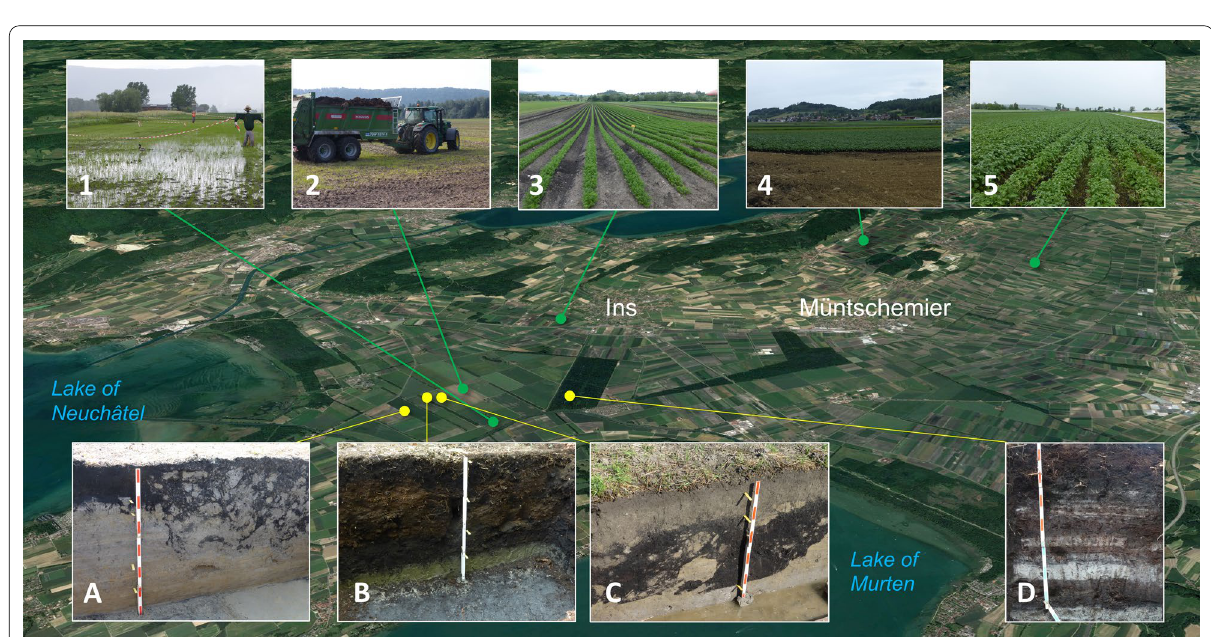
Fig. 3 Impressions of the investigation area (’Grosses Moos’): (1–5) actual agricultural land use [rice (newly introduced; (1), organic fertilising (2), carrots (3), ploughed arable land (4), potatoes (5)] and some typical soils with a deep-ploughed soil (right part of the picture) using a rotation system, b remaining peat bog in a forest, c deep-ploughed soil and layer (0–20 cm) with normal ploughing system, d peat bog having lake marl interlayers (forest; site S1; Fig. 4; aerial photo: Google